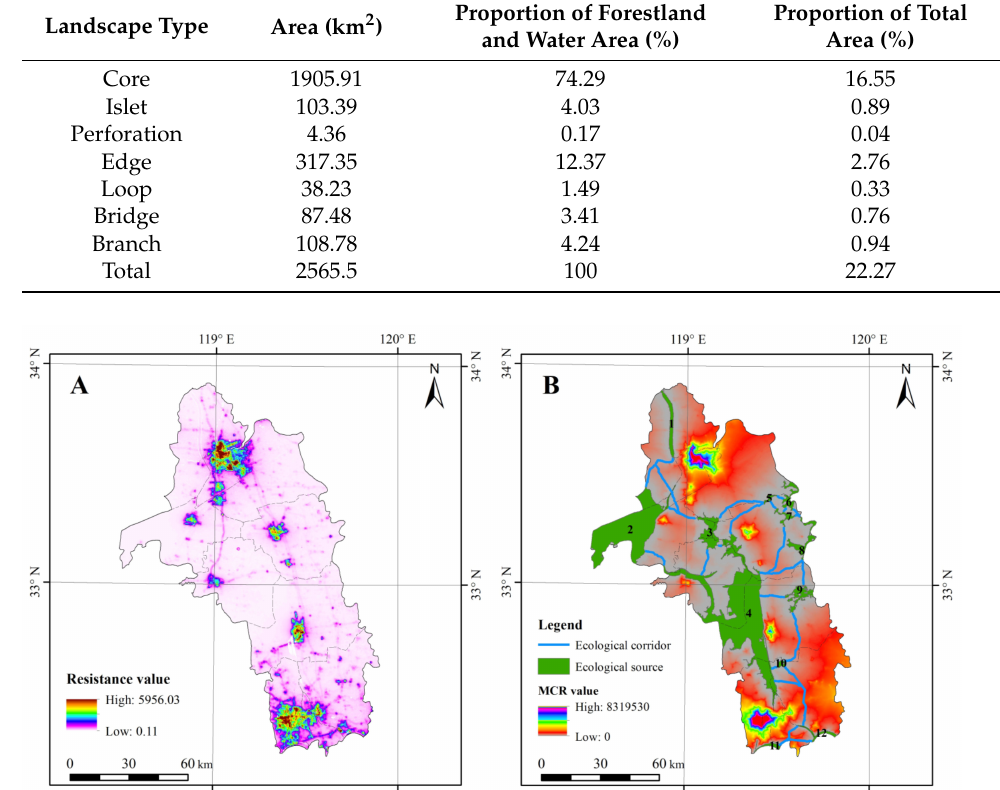
Figure 8. Ecological resistance surface ( A ) and spatial distribution of ecological corridors ( B